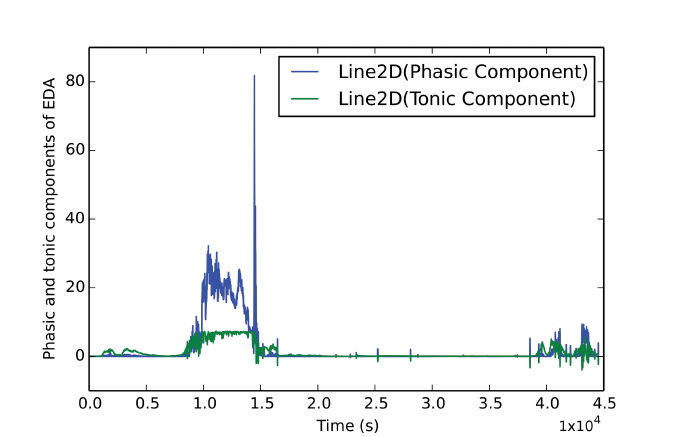
Figure 5. Decomposed EDA Signal from Empatica E4 wristband by applying cvxEDA